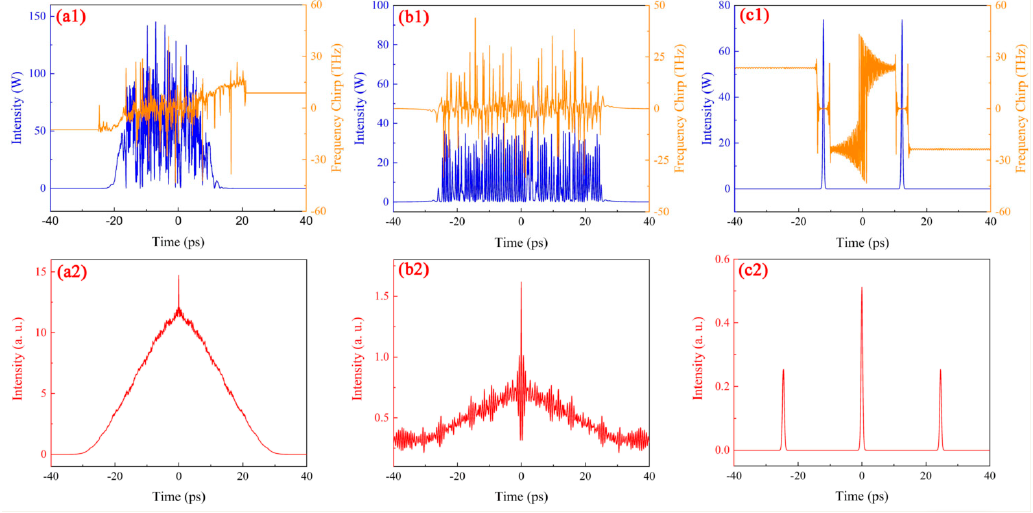
Figure 13. Typical pulse envelopes with the corresponding chirps at the net cavity dispersion of ( a1 ) 5.702 ps 2 , ( b1 ) − 1.448 ps 2 , and ( c1 ) − 21.688 ps 2 . ( a2 )–( c2 ) are the corresponding auto-correlation traces.